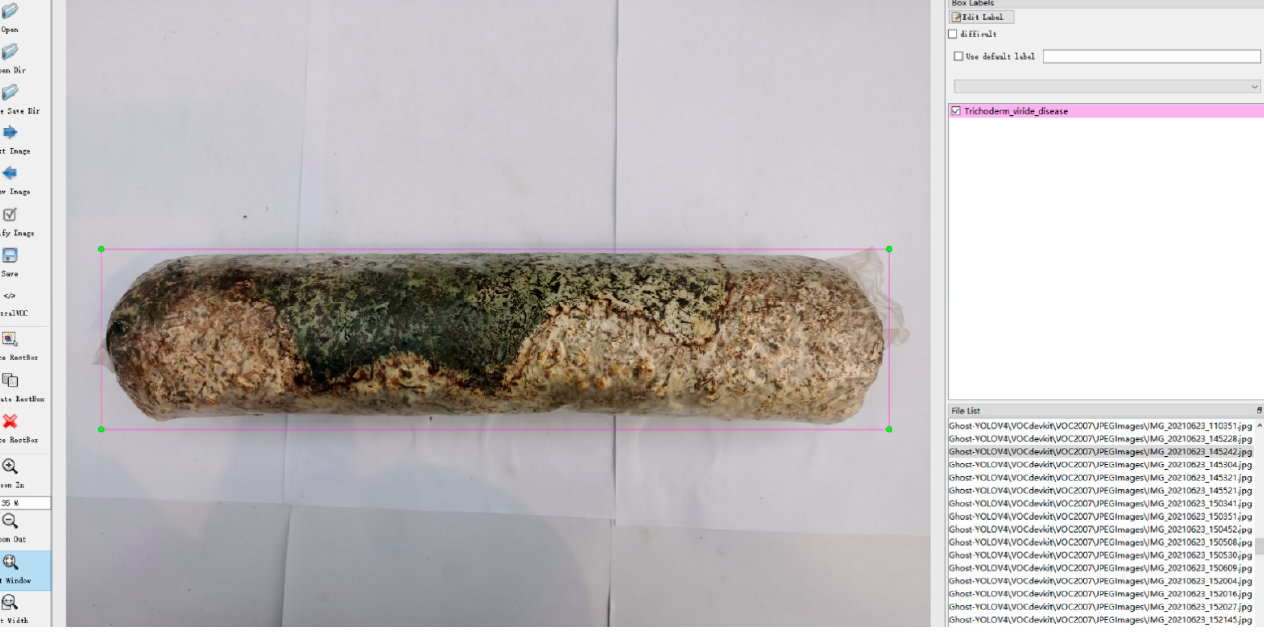
Figure 2. Annotation of Lentinula edodes log sundry bacteria contamination